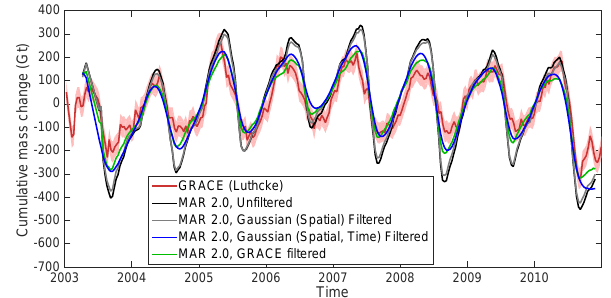
Figure 4. Detrended time series of cumulative GrIS-wide mass change, for GRACE-LM, MAR v2.0 (unfiltered), MAR v2.0 (GRACE-LM-filtered), and MAR v2.0 (Gaussian-filtered) for Jan- uary 2003–December 2010. Time series are shown for Gaussian- filtered MAR v2.0 outputs subject to only spatial filtering (gray curve) and both spatial and temporal filtering (blue curve). The pink shading indicates the range of error for the GRACE-LM time series.